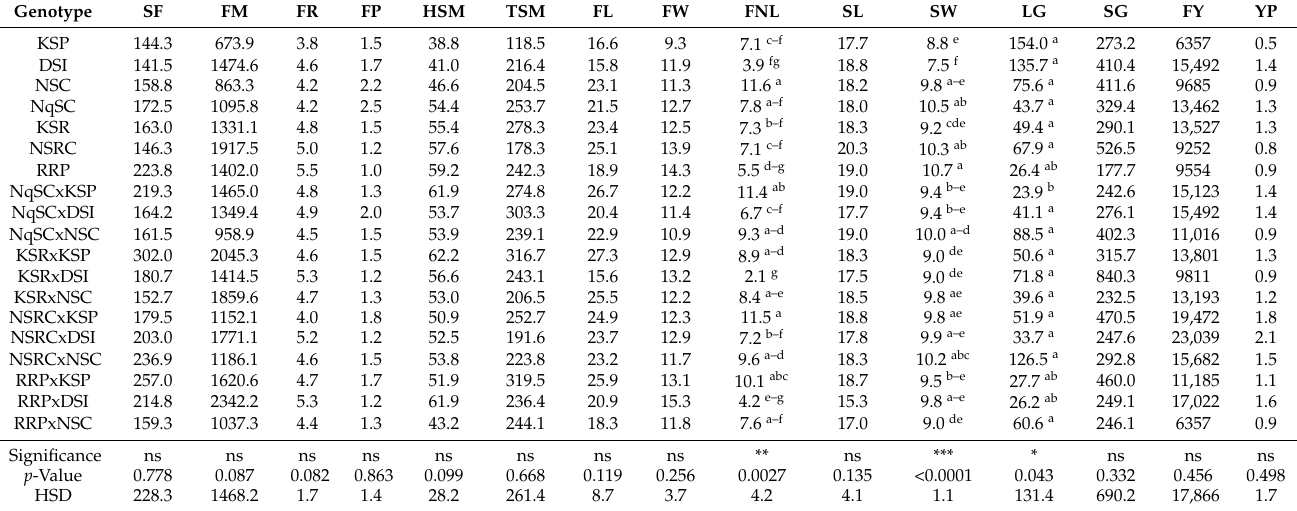
Table 4. Variation in fruit traits, seed traits, shoot and leaf growth (50 DAP), and yield traits among Lagenaria siceraria different